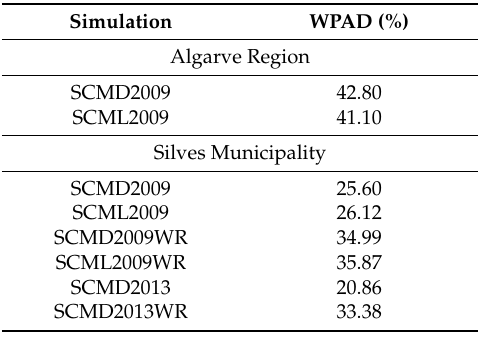
Table 3. The WPAD in the Algarve region Silves